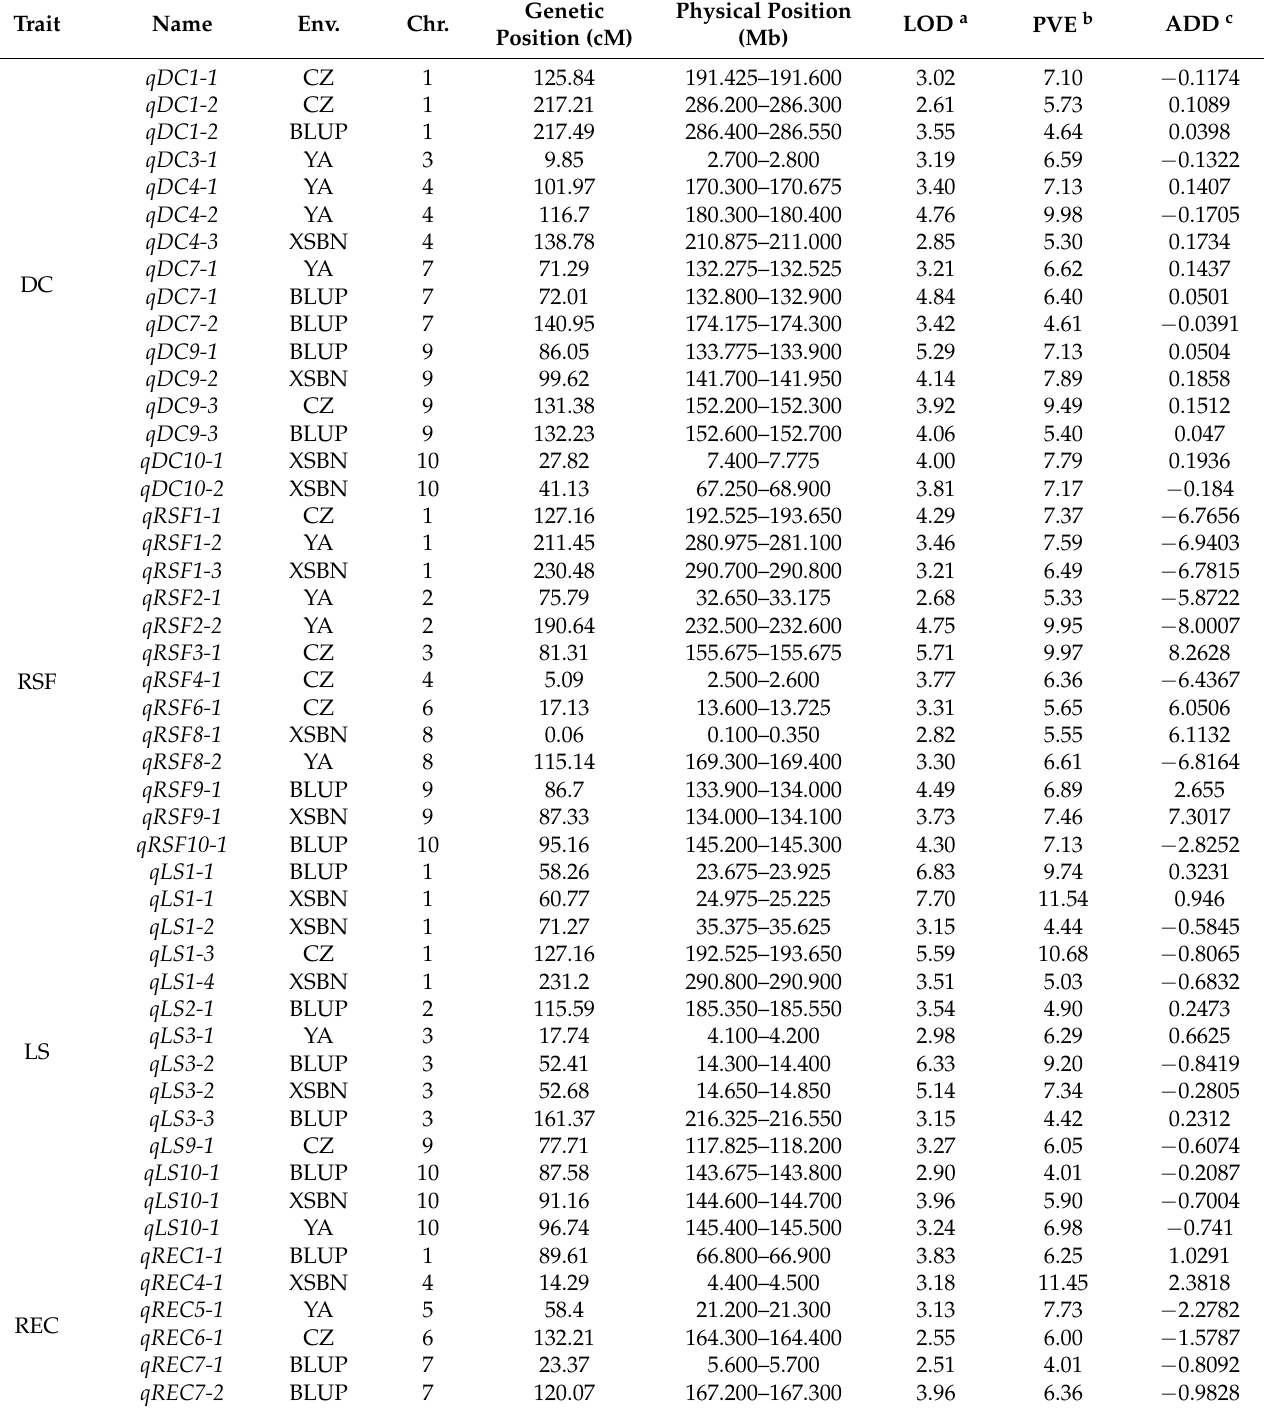
Table 4. QTLs controlling embryogenic callus induction-related traits across three